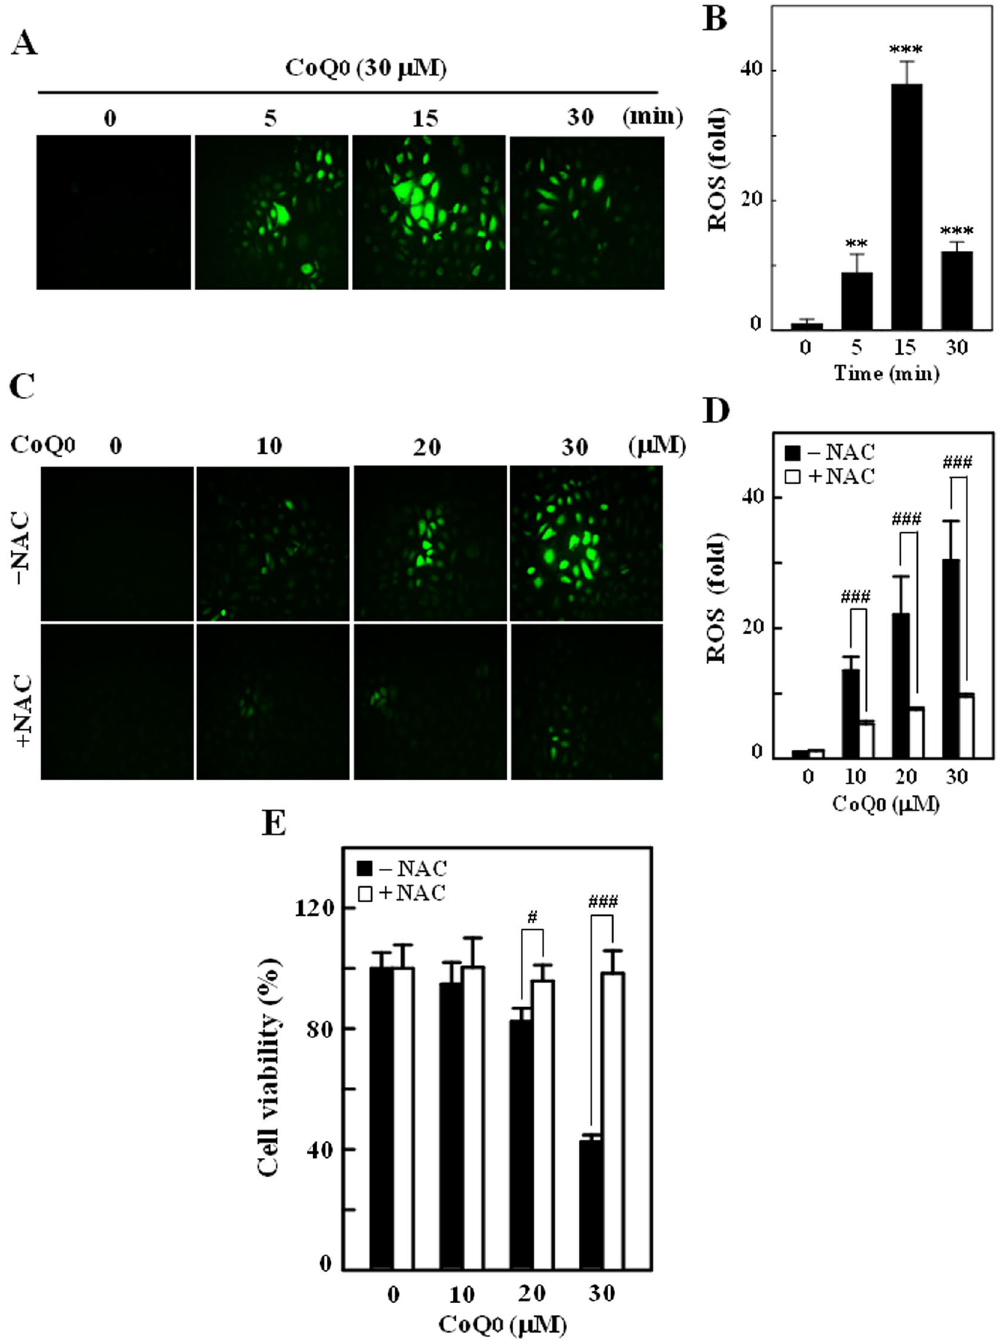
Figure 2. CoQ 0 induces intracellular ROS generation in SKOV-3 cells. ( A ) Cells were treated with CoQ 0 (30 µ M) for 0–30 min and generation of intracellular ROS were measured using fluorescent microscopy (200 × magnification). The non fluorescent probe DCFH 2 -DA reacts with cellular ROS and metabolized into fluorescent DCF. ( B ) The fluorescence intensity of DCF-stained cells, represent the levels of ROS was quantified by Olympus Soft Imaging Solution, and presented as histogram. Results are significant at ** p < 0.01; *** p < 0.001 compared to time 0 min. ( C ) Cells were treated with CoQ 0 (10–30 µ M) for 15 min, and ROS generation was measured in the presence or absence of ROS inhibitor (2 mM NAC, 1 h prior to CoQ 0 ). The levels of intracellular ROS were indicated by strong or weak fluorescence intensity. ( D ) ROS levels were quantified and expressed in bar diagram as percentage of control. ( E ) Cells were treated with ROS inhibitor (NAC, 2 mM) 1 h prior to CoQ 0 treatment (0–30 µ M, 24 h), and cell viability of was determined by MTT assay. Results expressed as mean ± SD of three independent assays (n = 3), and significant at # p < 0.1; ### p < 0.001 compared with CoQ 0 alone treated